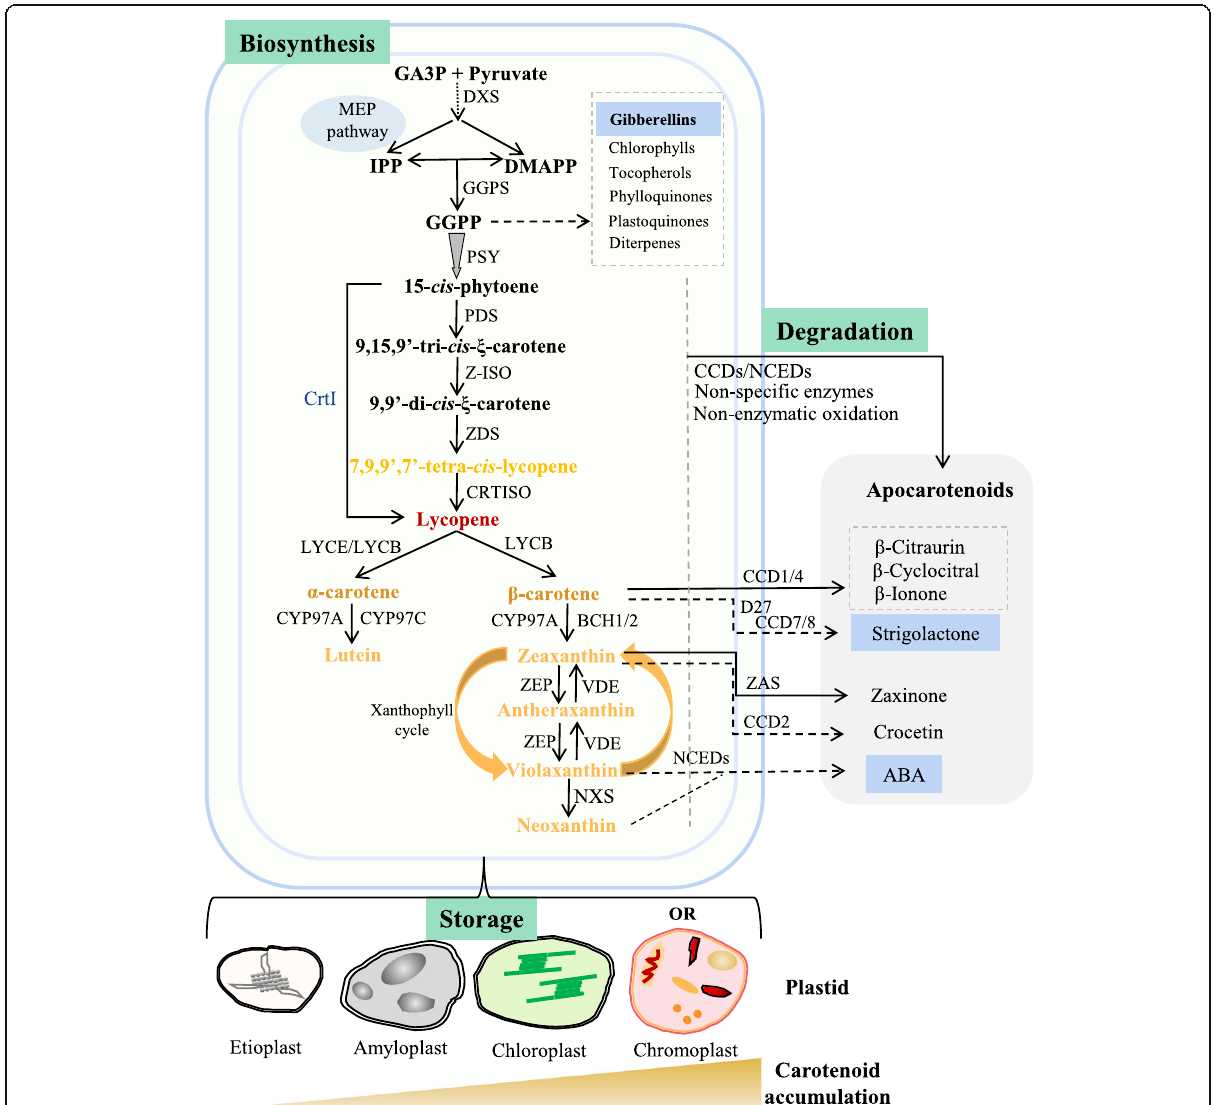
Fig. 1 A schematic diagram of plant carotenoid metabolic pathway in plastids. Carotenoid biosynthesis utilizes the plastidial MEP pathway to supply the C5 precursor metabolites IPP and DMAPP. The first committed step in the carotenoid biosynthetic pathway involves the condensation of two C 20 GGPPs into C 40 carotenoid phytoene catalyzed by PSY, a major rate-limiting enzyme for carotenoid biosynthesis. Carotenoid degradation involves specific enzymatic oxidative cleavages by CCDs and NCEDs, nonspecific enzymes, and non-enzymatic oxidation to produce diverse apocarotenoids including phytohormones ABA and strigolactones. Phytohormones are highlighted with blue color. Various plastids provide different storage capacity to accumulate very little of carotenoids in etioplasts to massive amounts of carotenoids in chromoplasts. OR is the only known bona fide regulator of chromoplast biogenesis. MEP, methylerythritol 4-phosphate; GA3P, glyceraldehyde 3-phosphate; IPP, isopentenyl diphosphate; DMAPP, dimethylallyl diphosphate; GGPP, geranylgeranyl diphosphate; DXS, 1-deoxy-D-xylulose 5-phosphate synthase; GGPPS, GGPP synthase; PSY, phytoene synthase; PDS, phytoene desaturase; Z-ISO, ζ -carotene isomerase; ZDS, ζ -carotene desaturase; CrtISO, carotenoid isomerase; CrtI, bacterial phytoene desaturase; LCYE, lycopene ε -cyclase; LCYB, lycopene β -cyclase; BCH, β -carotene hydroxylase; CYP97A, cytochrome P450 carotene β -hydroxylase; CYP97C, cytochrome P450 carotene ε -hydroxylase; ZEP, zeaxanthin epoxidase; VDE, violaxanthin de-epoxidase; NXS, neoxanthin synthase; CCD, carotenoid cleavage dioxygenase; NCED, 9- cis -epoxycarotenoid dioxygenase; ZAS, zaxinone synthase; ABA, abscisic acid; OR, ORANGE